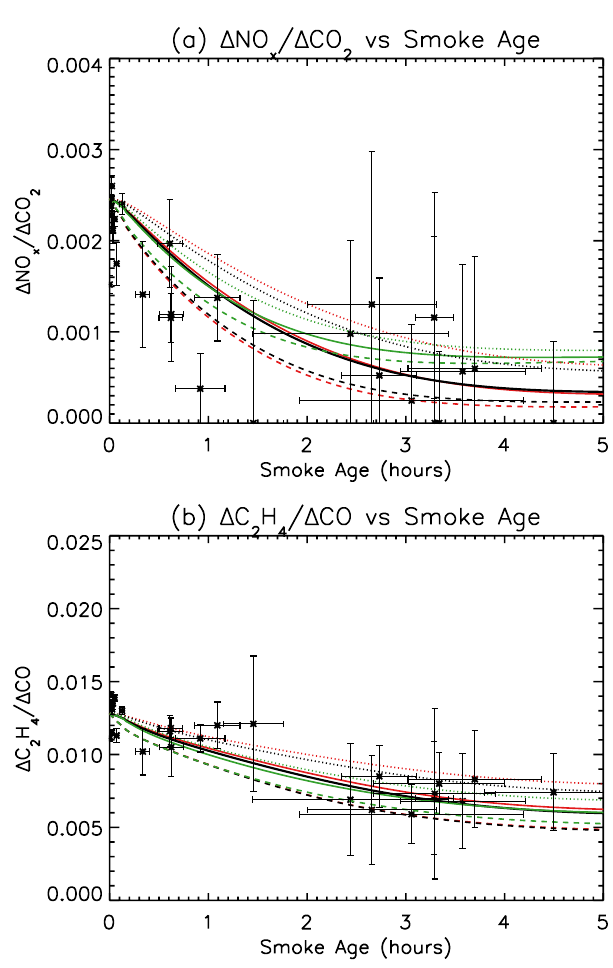
Figure 14. As in Fig. 6, but for the optimized SVOC chemistry (see Table